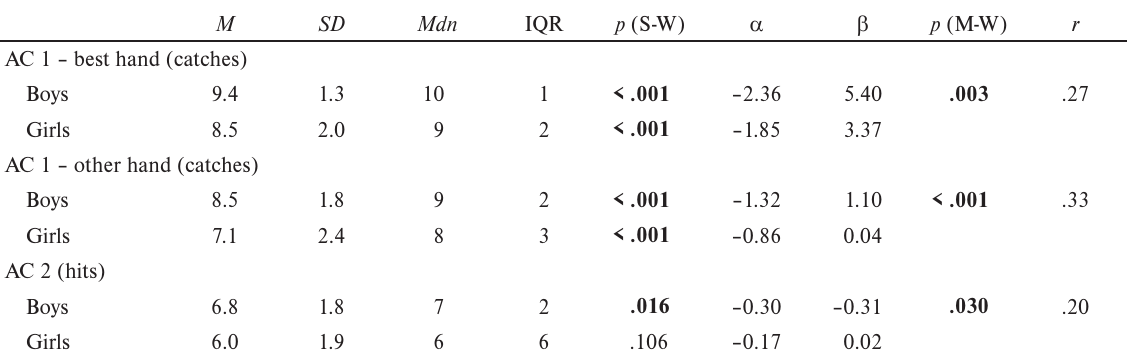
Descriptive characteristics of performance in the aiming and catching tasks M